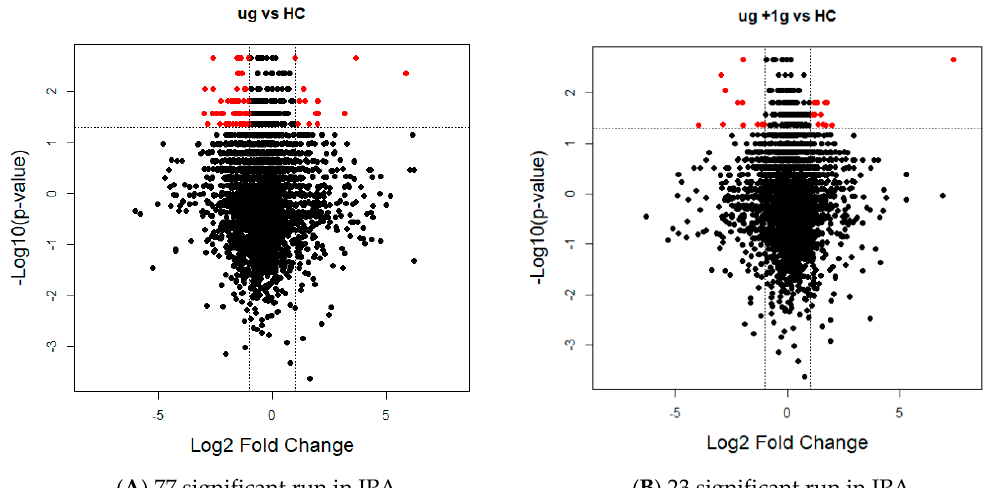
Figure 4. Volcano plots show differentially expressed proteins (FDR adjusted p < 0.05 and fold change >2). ( A ) µg versus HC: 77 significant run in Ingenuity Pathway Analysis (IPA); ( B ) µg + 1 g versus HC: 23 significant run in IPA. Volcano plots were generated based on fold-change of protein levels using the log 2 normalized iBAQ intensities from six biological replicates. The x-axis indicates a log 2 fold-change and the y -axis indicates − log 10 p -value based on a Mann–Whitney U test with a FDR adjusted p -value. The horizontal line indicates a p -value < 0.05 and the vertical lines represent a fold- change